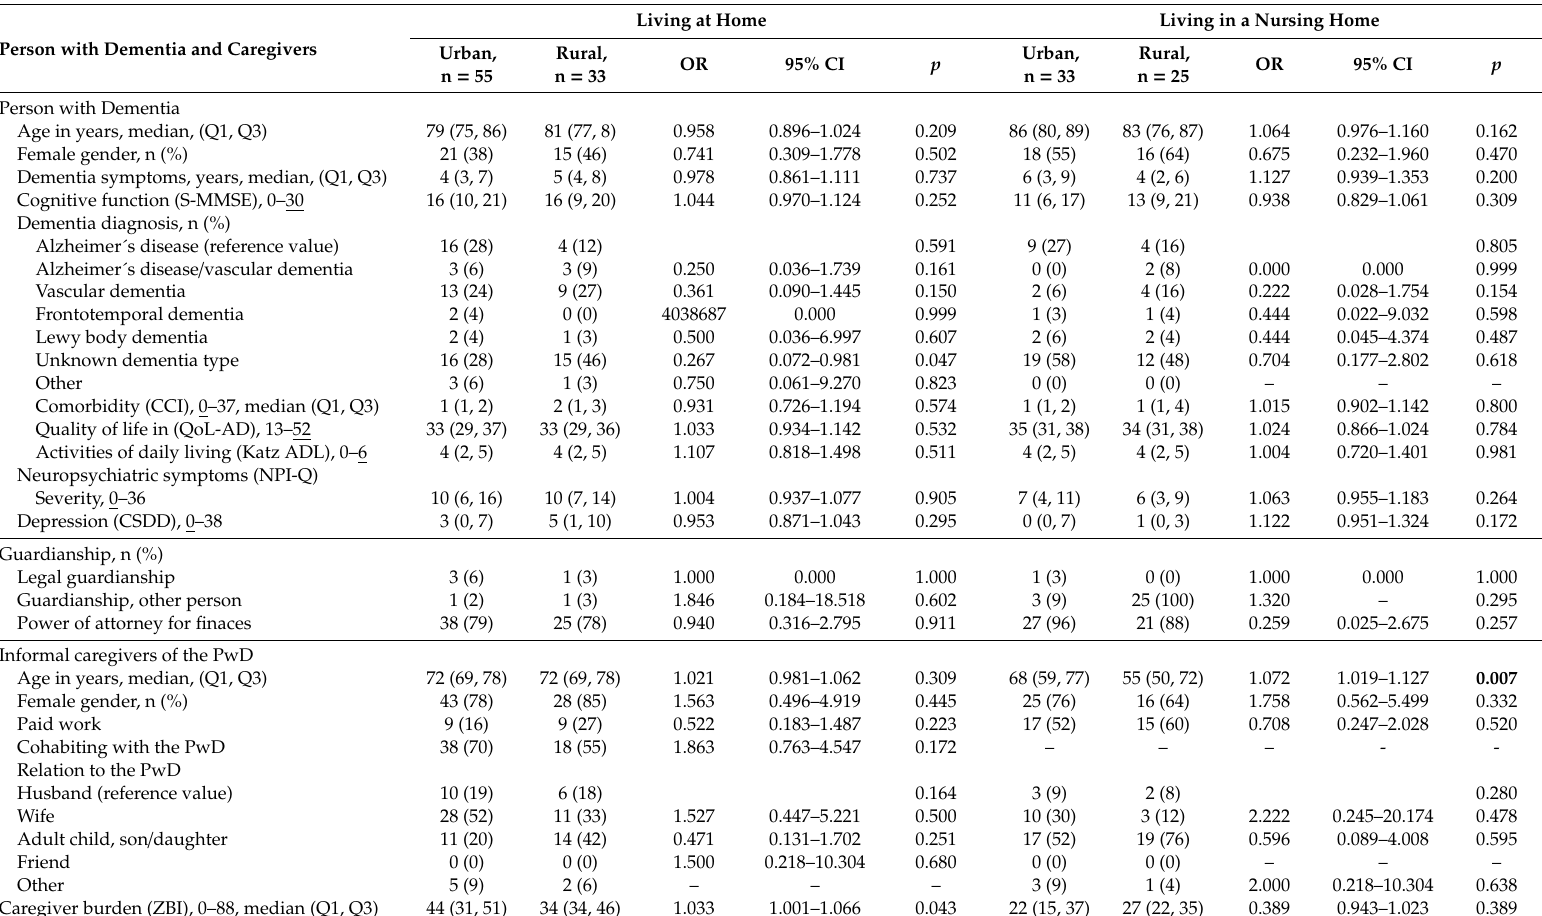
Table 3. Bivariate regression analysis and associated factors of persons with dementia and informal caregivers in urban versus rural areas. Living at Home Living in a Nursing Home Person with Dementia and Caregivers Urban, n = 55 Person with Dementia Age in years, median, (Q1,